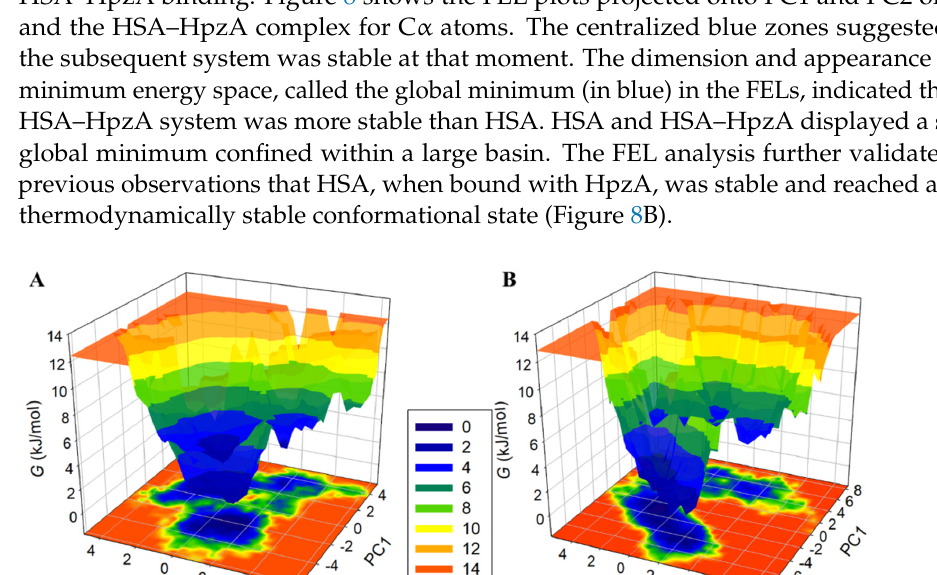
Figure 7. Principal component analysis. (A) Two-dimensional projections of HSA trajectories on eigenvector 1 and eigenvector 2. ( B ) Time evaluation of conformational projections of trajectories on eigenvector 1 and eigenvector 2.